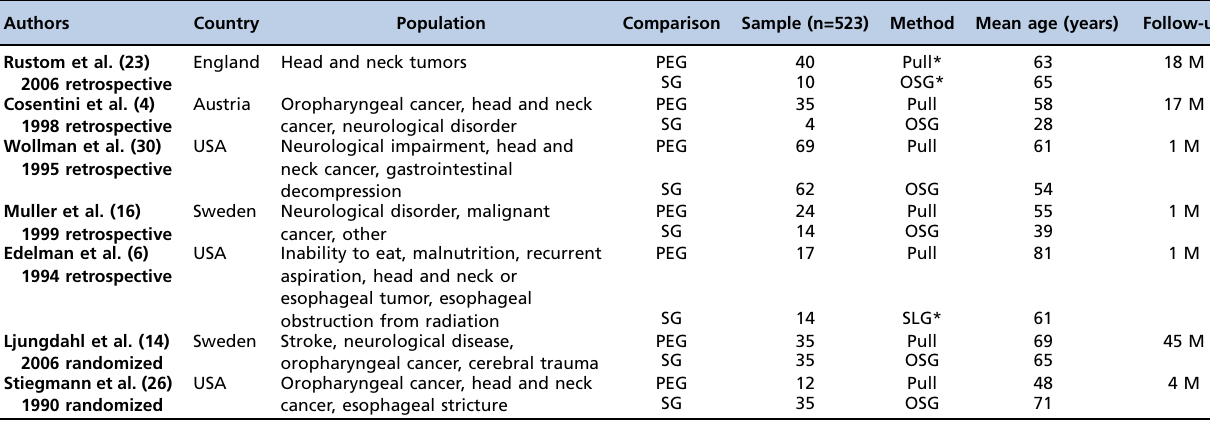
Table 1 - Characteristics of retrospective and randomized